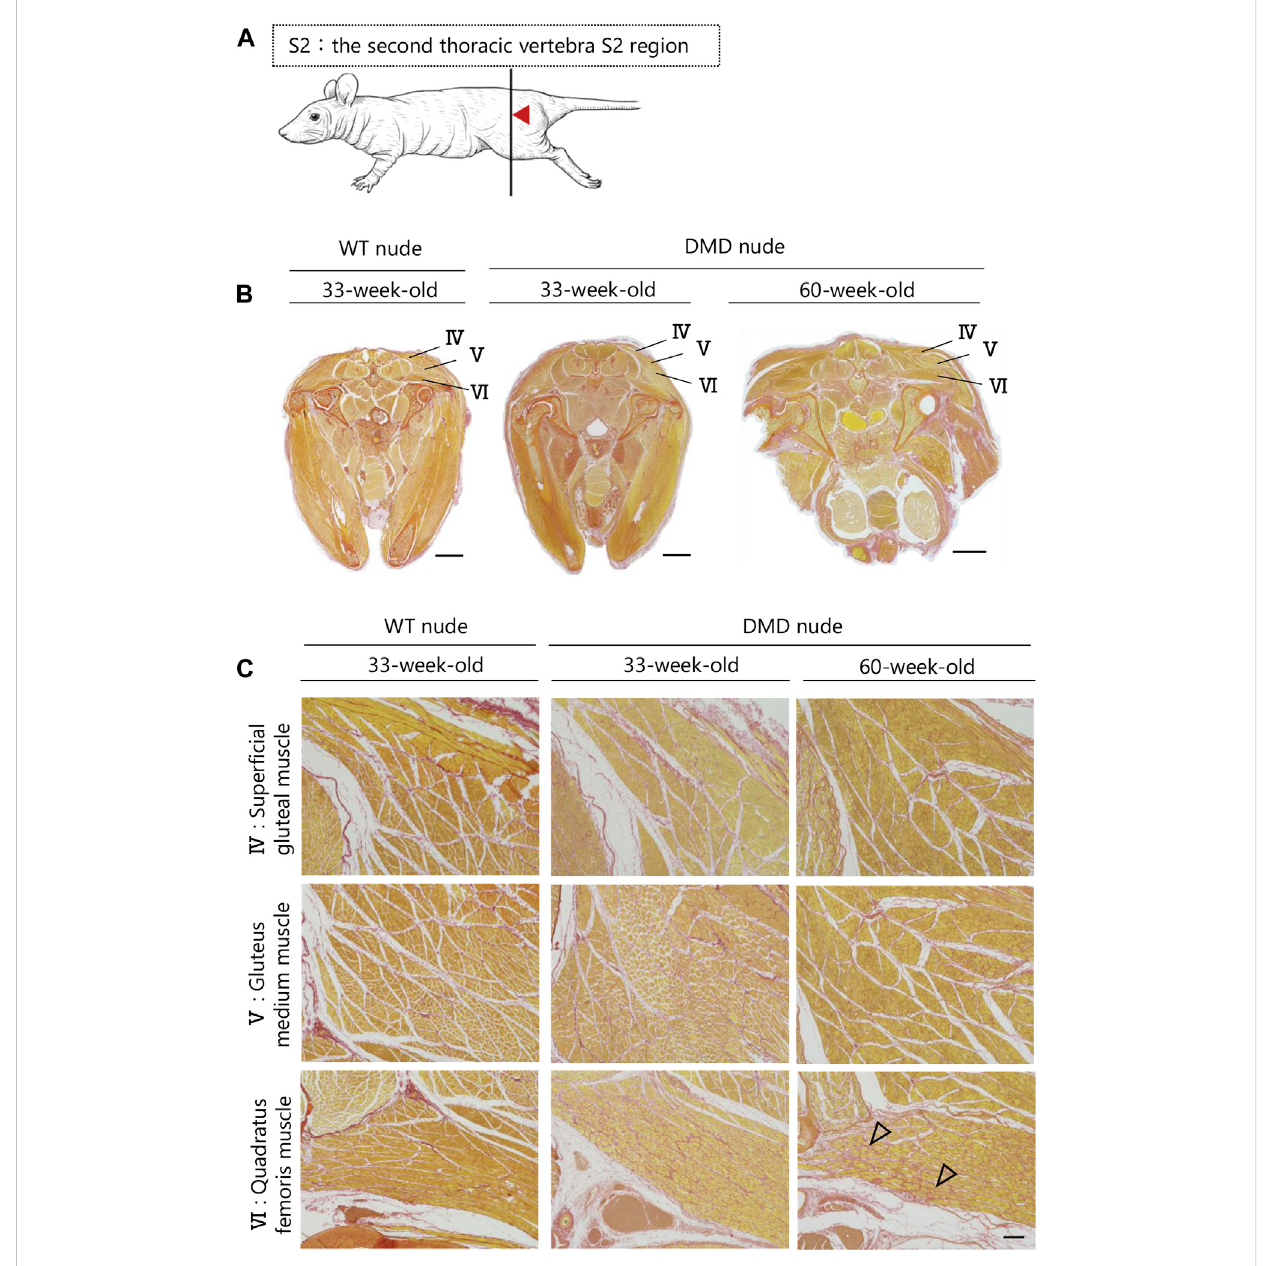
FIGURE 6 Lesiondistributionwithintheskeletalmuscle intransversesectionsinDMD nuderats. (A) Schematic drawingshowingthesectioning locationofthe rump.ThecutsweremadeinthespinousprocessofthesecondthoracicvertebraS2region(S2). (B) RepresentativeimagesofSiriusred(SR)stainingatthe S2 lumbarsection ofeach typeofrat to evaluate thedegree of fi brosis.Scale bar= 5 mm. (C) Magni fi edviewsof IV,V, andVI from (B) indicated byarrows are shown in the lower columns. Scale bar = 300 µm. The symbols, ▽ indicates fi